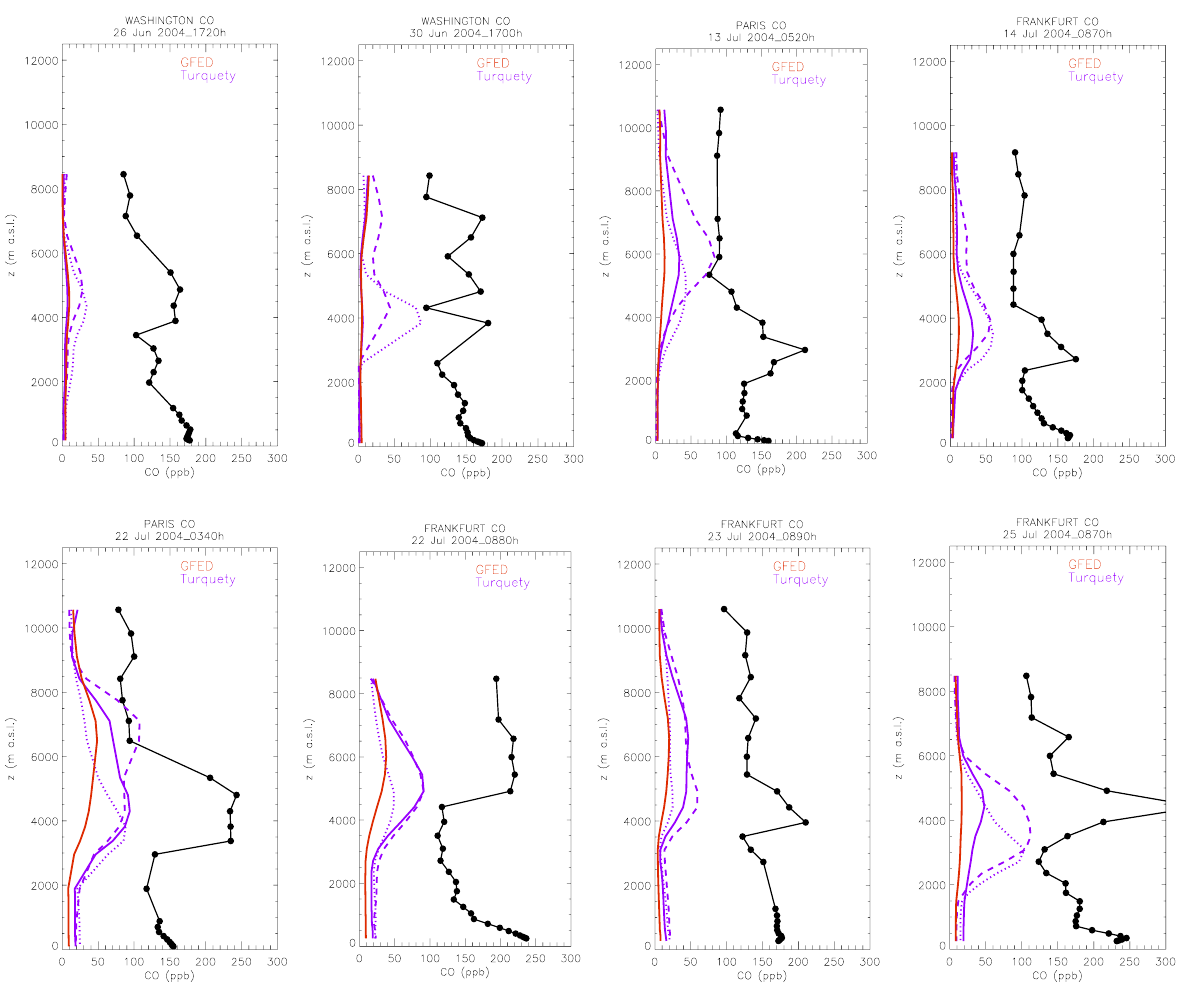
Fig. 12. Vertical profiles of modelled tracer CO with GFED 8-daily emissions (red line) and Turquety daily emissions (purple line) from biomass fires and observed CO (black line). Solid lines indicate tracers injected at the surface. Dotted and dashed lines represent the tracers injected at 6 and 8km,